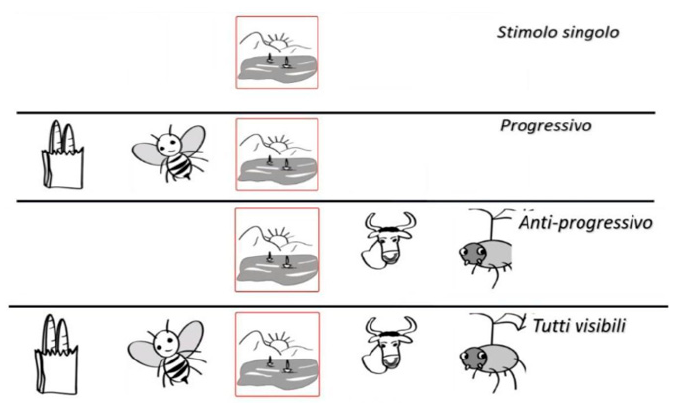
Figure 1. Types of stimuli presentation (in order single stimulus, progressive, anti-progressive and all visible).